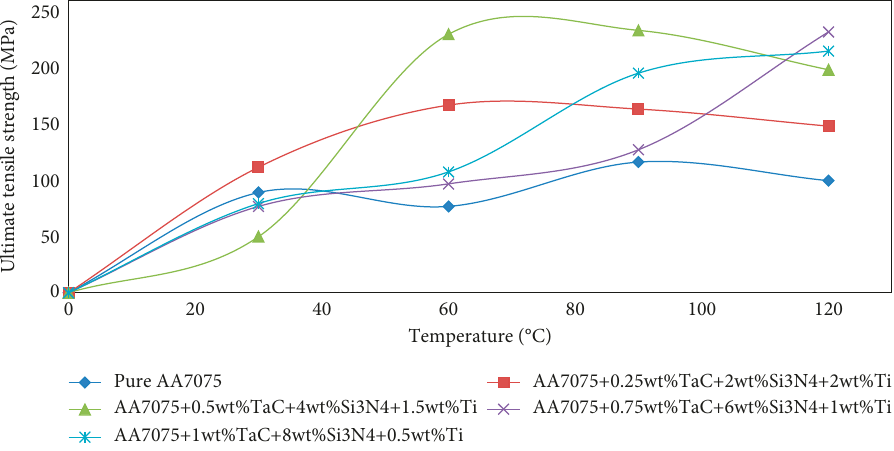
Figure 12: Deviation of UTS versus temperatures of the developed